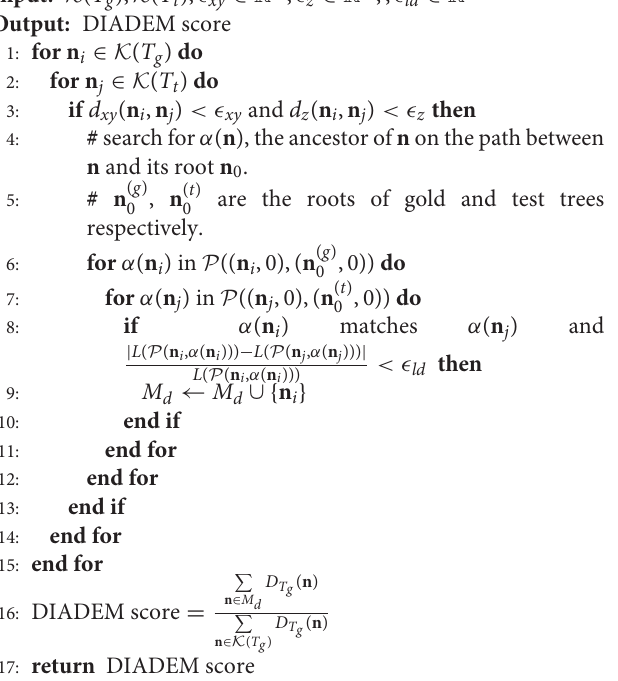
Algorithm 4: Diadem metric.